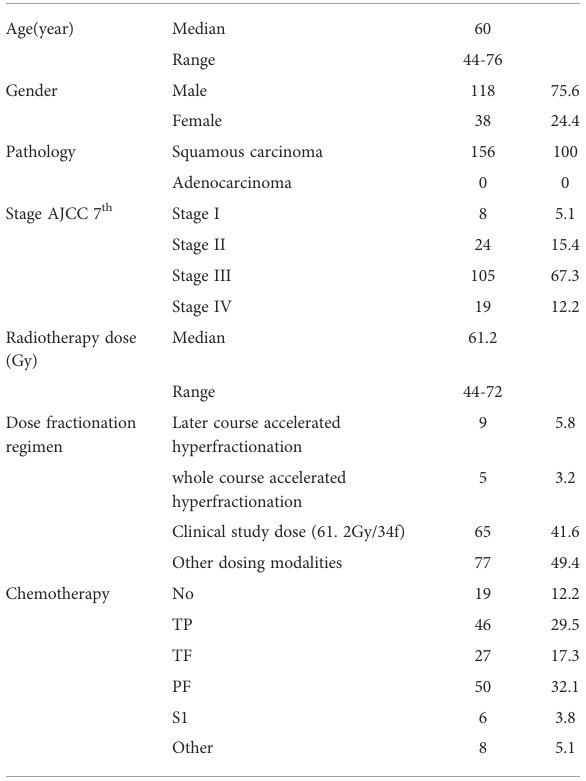
TABLE 1 General information of